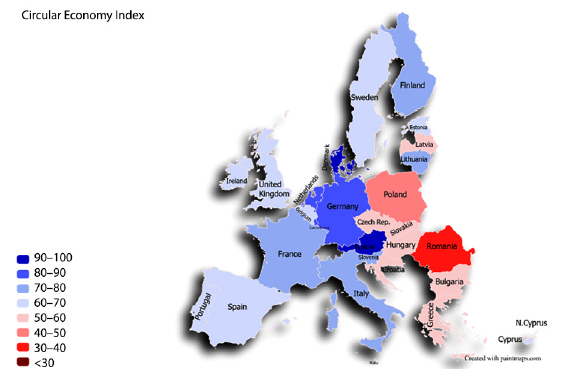
Figure 3. Circular Economy Index for UE country (source: created by the authors using Color maps with statistical data, Paintmaps,